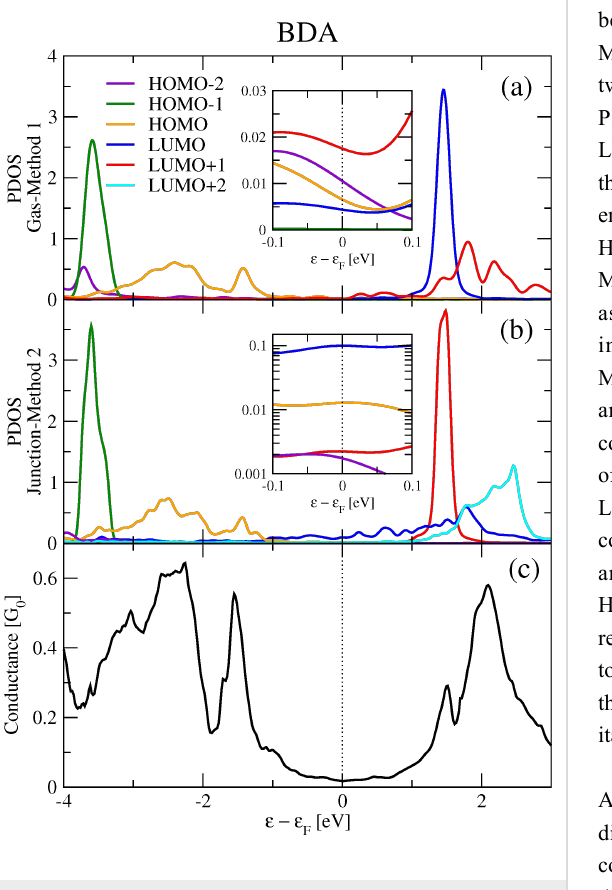
Figure 2: Projected density of states (a,b) and conductance (c) of benzene-diamine (BDA). The PDOS for the different molecular orbitals (from HOMO − 2 to LUMO+1) have been obtained with (a) Method 1 and (b) Method 2 (see text). The insets show a zoom on the PDOS around the Fermi energy region. Notice that in the inset of (b), the PDOS is presented in logarithmic